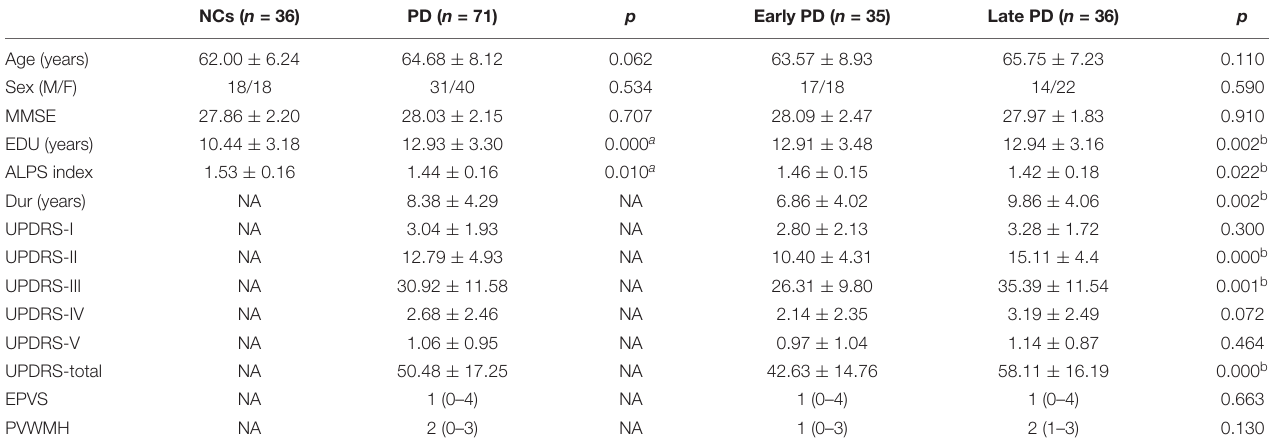
TABLE 1 | Demographic and clinical data of the subjects.